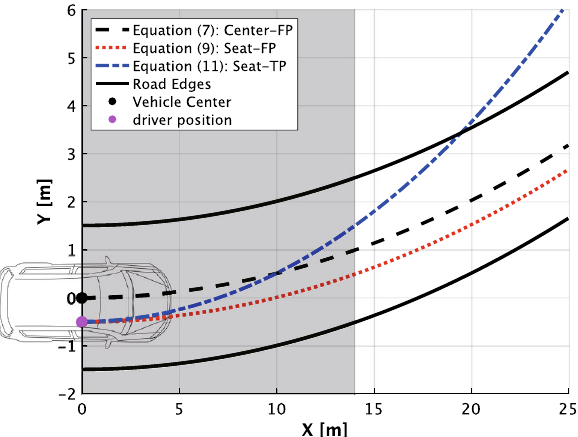
Figure 4. Comparison of the FoEs. [0, 0] is the position of the center of the vehicle. [ 0, − 0.5 ] is the driver’s head position. The black, red, and blue dotted lines represent the FoEs by (7), (9), and (11), respectively. A gray zone denotes that TP gaze is recommended because the distance between the black and blue dotted lines is smaller than the distance between the black and red dotted